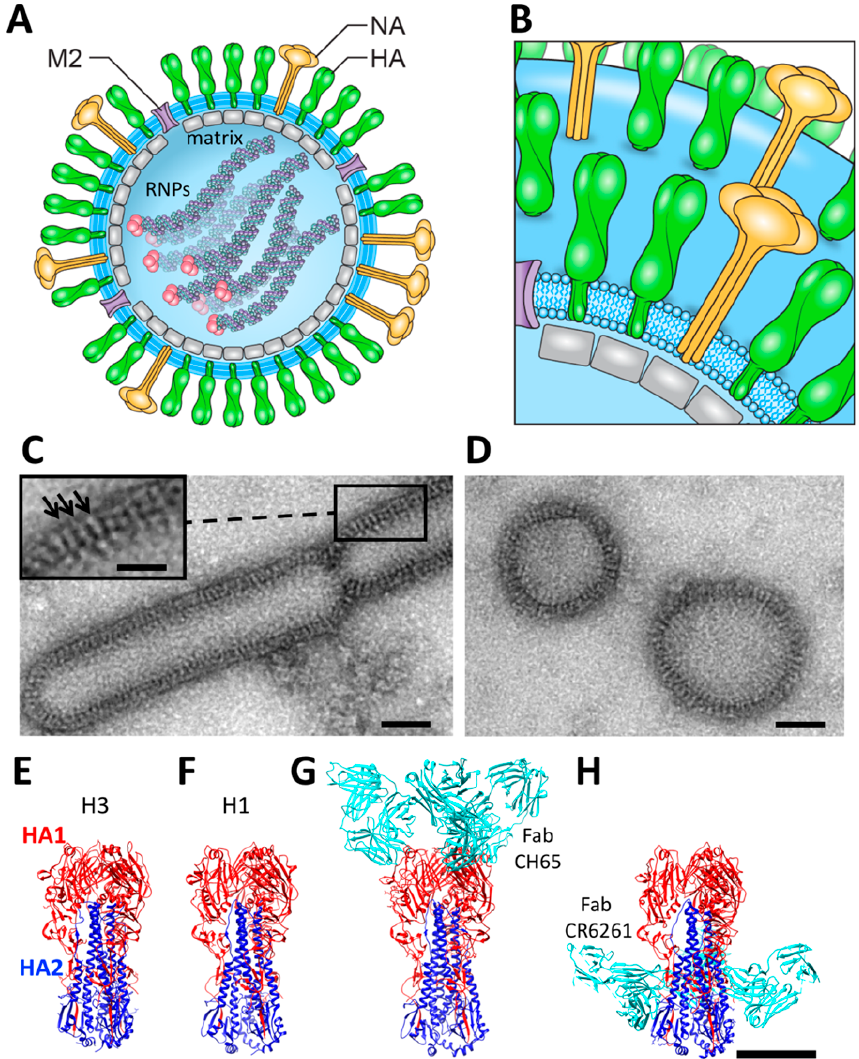
Figure 1. Influenza virus organization and hemagglutinin (HA) structure. ( A ) schematic of an influenza virus particle. Viral glycoproteins are hemagglutinin (HA, green); neuraminidase (NA, yellow); matrix 2 (M2) (purple). The membrane is shown in light blue. Genomic ribonucleoprotein complexes (RNP) filaments are inside with a trimeric viral polymerase complex (pink) at the end of each RNP; ( B ) the most populous glycoprotein on the virion surface is HA, which is accompanied by lesser amounts of NA, and a minority of M2; ( C , D ) influenza virus particles negatively stained with PTA; ( C ) Influenza virus, A/Victoria/3/75 (H3N2), displaying filamentous morphology. Scale bar, 50 nm; ( C , inset) individual glycoprotein spikes on the virion surface are indicated with arrows. Scale bar, 25 nm; ( D ) A/Victoria/3/75 virions with spherical morphologies. Scale bar, 50 nm; ( E – H ) trimeric HA ectodomains solved by protein X-ray crystallography. HA1 is shown in red and HA2 is blue with Fabs in cyan. ( E ) H3 HA (PDB 4O5N); ( F ) H1 HA (PDB 3LZG); ( G ) H1 HA in complex with Fab CH65 bound to receptor binding site (PDBID 5UGY); and ( H ) H1 HA in complex with Fab CR6261 bound to the stem region (PDB 3GBN). Scale bar, 5 nm. Panel images are originals created for this review.